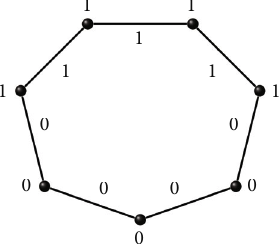
Figure 1: Total product cordial labeling of cycle C